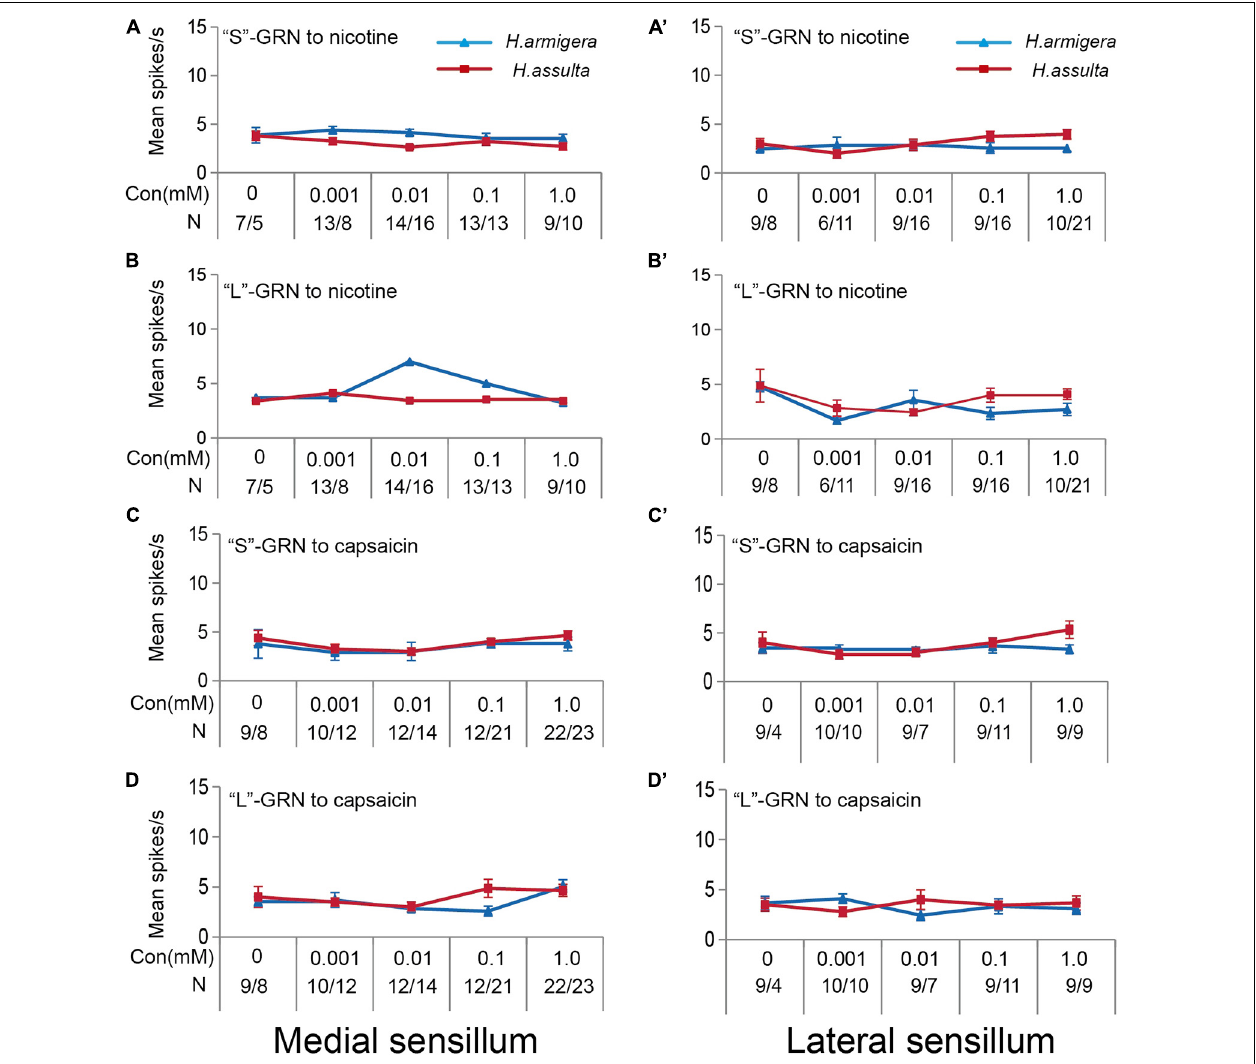
FIGURE 9 | Responses of “S” and “L” GRNs in the styloconic sensilla of Helicoverpa caterpillars to nicotine and capsaicin. (A,A’) : responses to nicotine of the indentified “S” GRNs from the medial and lateral sensillum, respectively; (B,B’) : responses to nicotine of the indentified “L” GRNs from the medial and lateral sensillum, respectively; (C,C’) : responses to capsaicin of the indentified “S” GRNs from the medial and the lateral sensillum, respectively; (D,D’) : responses to capsaicin of the indentified “L” GRNs from the medial and the lateral sensillum, respectively.